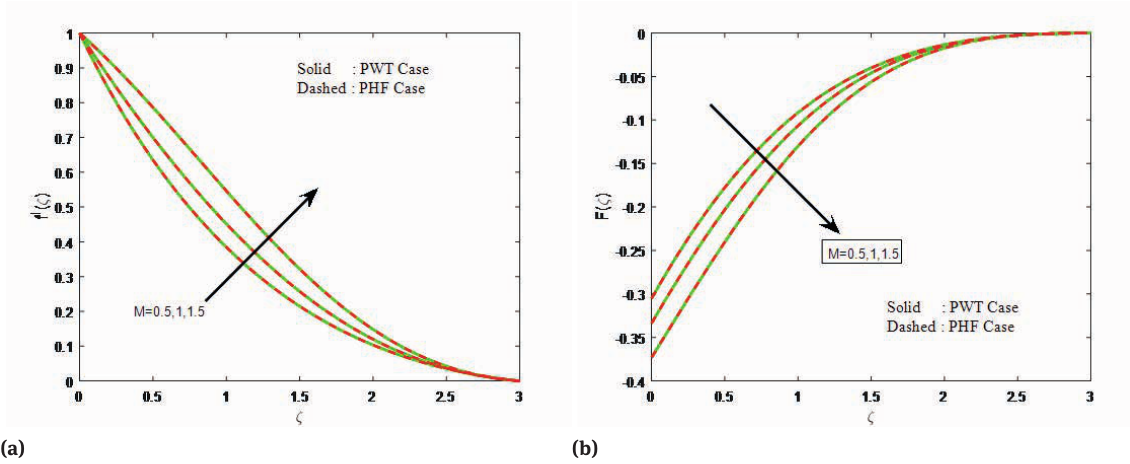
Fig. 3: a,b) Velocity profiles with varying magnetic parameter (M). Table 1: Validation of the local Nusselt number ( − θ (cid:2) (0) ) for the case of λ = 0, β = 0, Ec = 0, γ = 0. Pr Grubka and Bobba [8] Abel and Mahesha [12] Ramesh et al. [23]